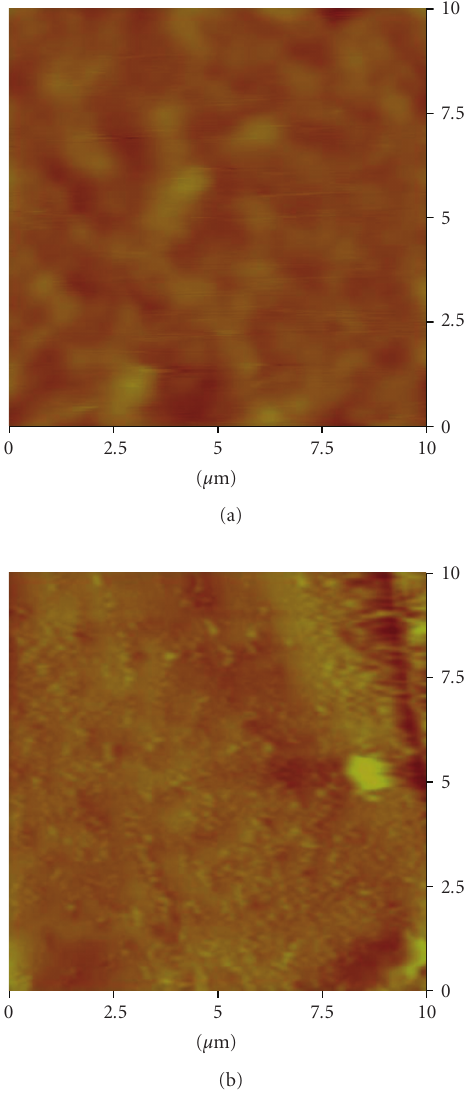
Figure 6: AFM Images of (a) Virgin PP (b) IPP-g-MMA.